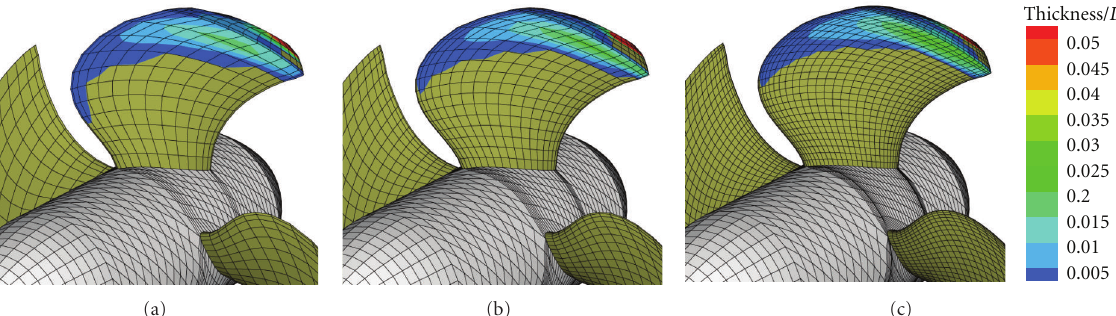
Figure 10: Convergence of cavity extension with the number of panels. Open water thrust coe ffi cient equal to 0.213 at cavitation index of 1.625.